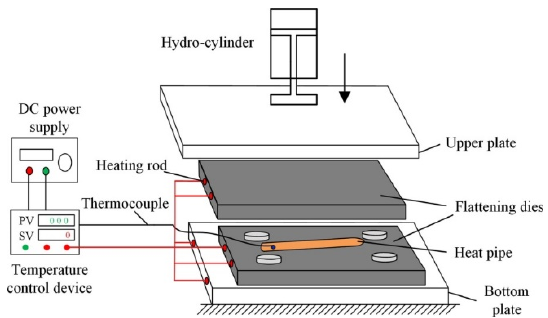
Figure 11. Schematic diagram of the phase-change flattening process